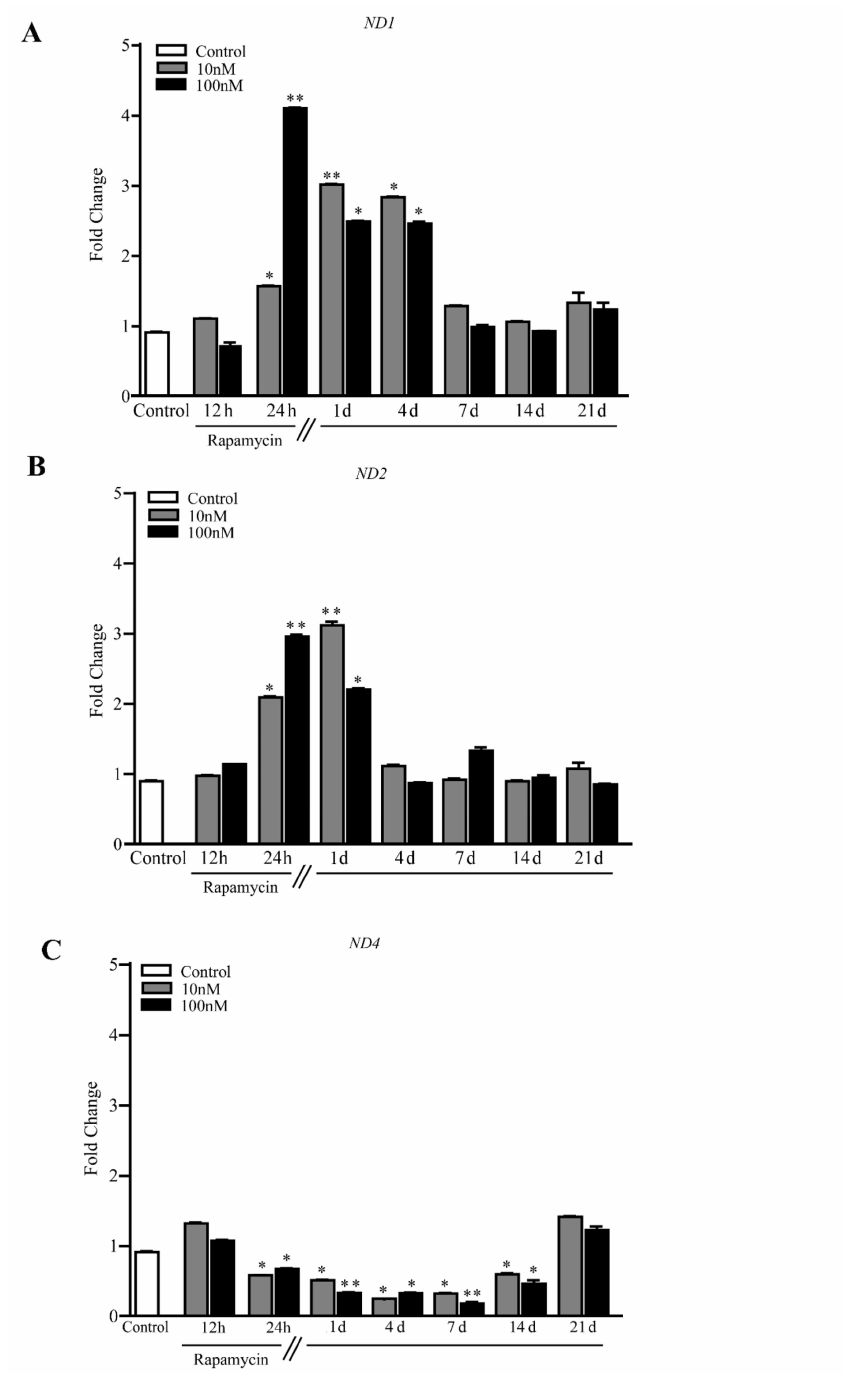
Figure 11. Rapamycin increases mRNA levels for ND1 and ND2 while decreasing ND4 within U87MG cells. RT-PCR for ( A ) ND1 , ( B ) ND2 and ( C ) ND4 . * p ≤ 0.05 vs. Control. ** p ≤ 0.05 vs. Control and 10 nM rapamycin. Each RT-PCR was performed in triplicate and confirmed in two independent experiments using both beta-globin and beta-actin as internal